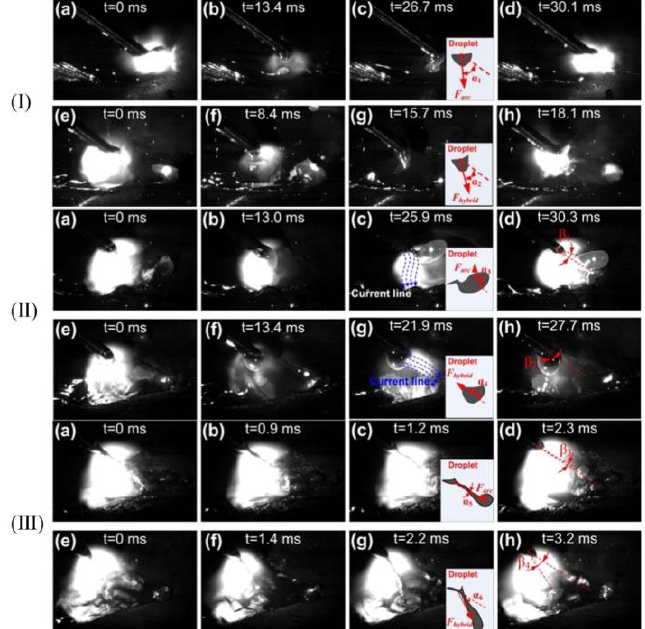
Figure 22. Short-circuit transfer ( I ), globular transfer ( II ), spray transfer ( III ); order of droplets: ( a – d ) arc welding and ( e – h ) hybrid welding [104]. Reprinted with permission from [104] 2016